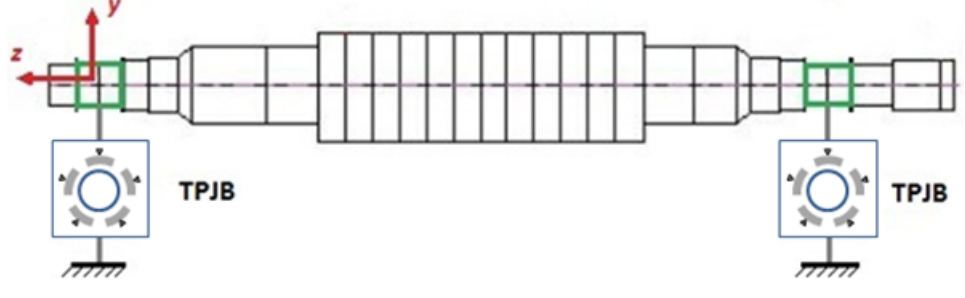
Figure 9. Bearings and rotor fractions modeled by solid